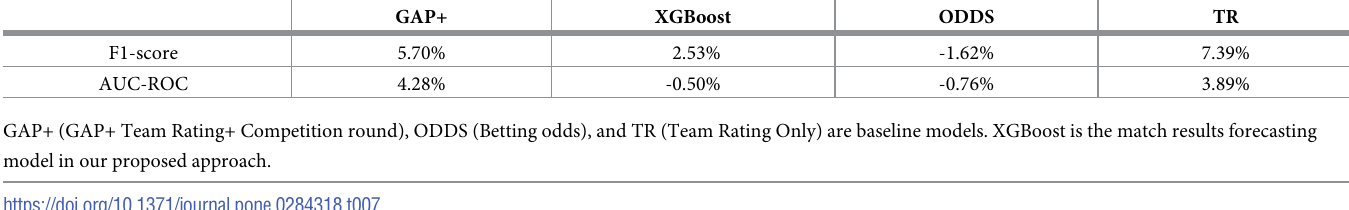
Table 7. Match results forecasting models’ performance percentage change after excluding competition rounds 1–6 and 33–38.